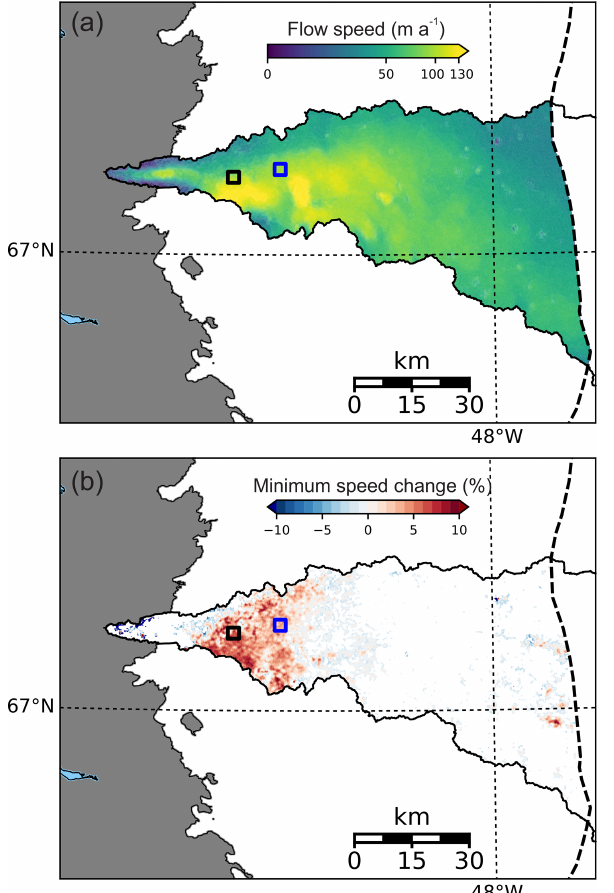
Figure 4. Spatial characteristics of ice flow across Isunnguata Ser- mia basin during winter 2017–2018 based on the MEaSUREs v2 product. (a) Pattern of ice flow speed during early winter measured over the month of October 2017. (b) Minimum ice speed change (as percentage) from October through April; shown are the percentage speed changes minus the potential percentage change resulting from error terms. Areas showing no change could have potentially experi- enced an October–April speed change, but not enough to overcome errors. The 33 and 46km measurement sites are shown as boxes.